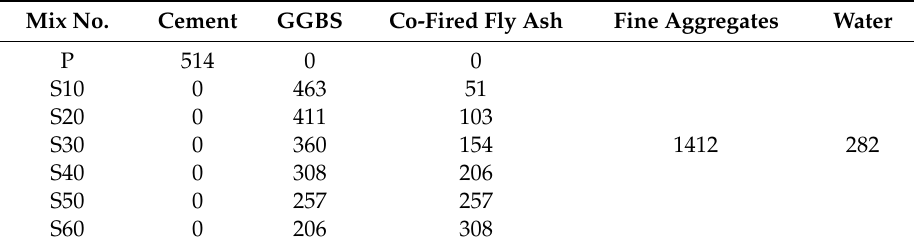
Table 3. Mix design of the mortar specimens for a preliminary test (kg / m 3 ).